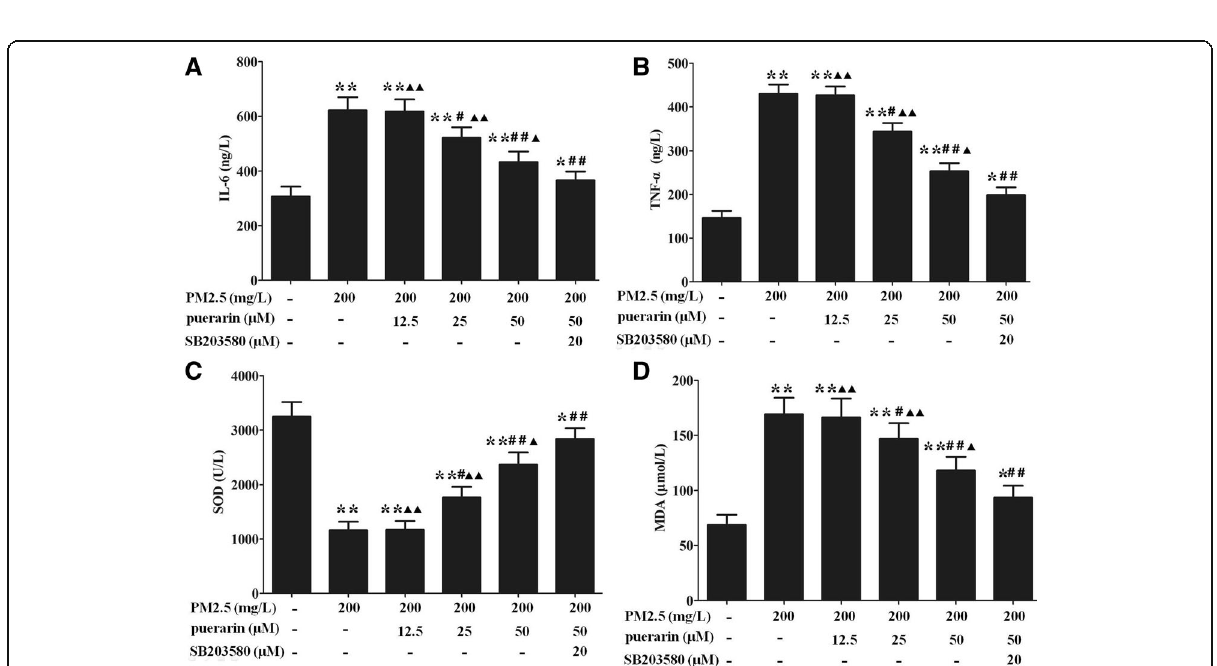
Fig. 5 Effect of puerarin on the levels of inflammatory and oxidative stress biomarkers in VSMCs. Cells were pre-treated with puerarin at different concentrations (0, 12.5, 25, 50 μ M) or p38 MAPK inhibitor SB203580 (20 μ M) for 1 h and followed by the addition of 200 mg/L PM2.5 for 24 h. a IL-6 level was measured by ELISA. b TNF- α level was measured by ELISA. c SOD level was assayed by colorimetric assay kit. d MDA level was assayed by colorimetric assay kit. The results are presented as mean ± SEM. n = 3. Compared to the untreated cells, * P < 0.05, ** P < 0.01; compared to 200 mg/L PM2.5 group, # P < 0.05, ## P < 0.01; compared to the co-incubation of puerarin with SB203580 group, ▲ P < 0.05, ▲▲ P <